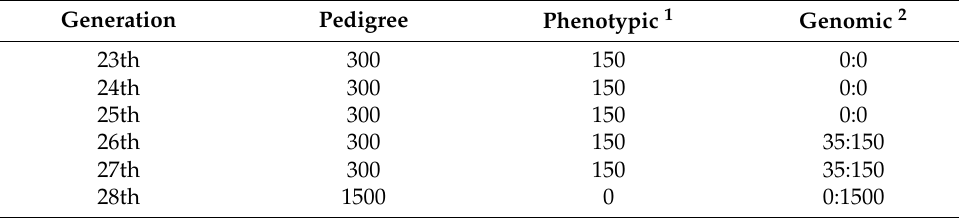
Table 2. Number of data used in the genomic analyses per